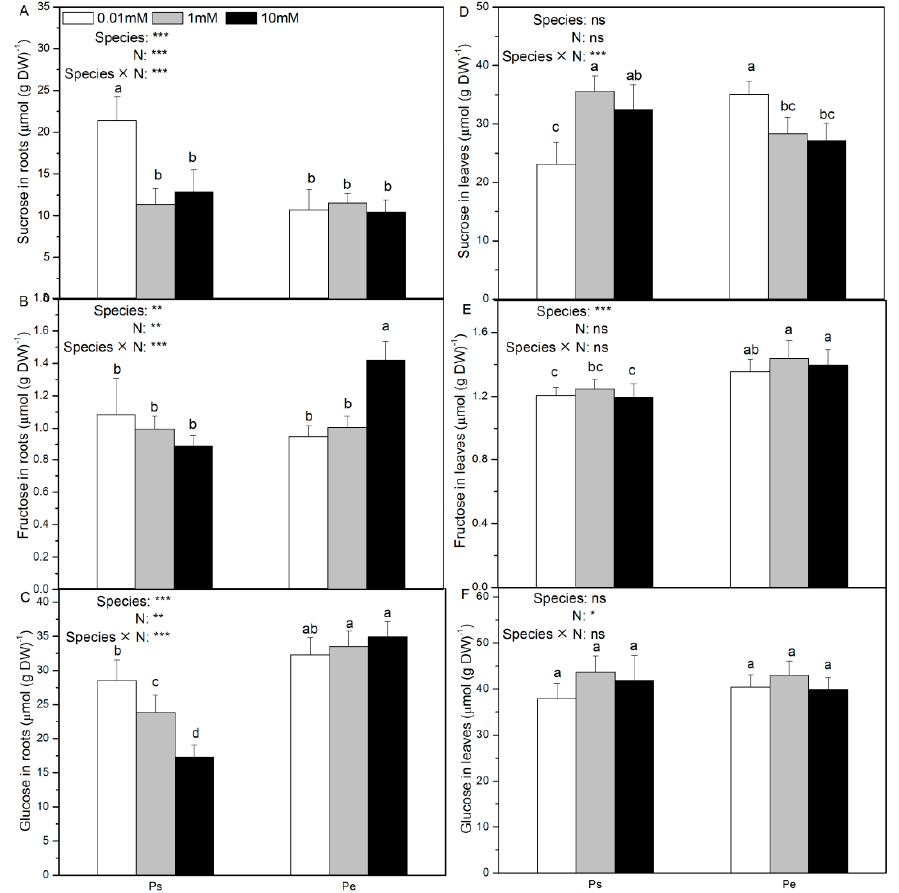
Figure 2. Contents of sucrose ( A , D ), fructose ( B , E ) and glucose ( C , F ) of P. simonii (Ps) and Populus euramericana (Pe) under 0.01, 1, and 10 mM NH 4 NO 3 . Bars labelled with different letters indicate significant difference between the treatments. p -Values of the ANOVAs of species, N treatment, and their interaction are indicated. * p < 0.05; ** p < 0.01; *** p < 0.001; ns, not significant.